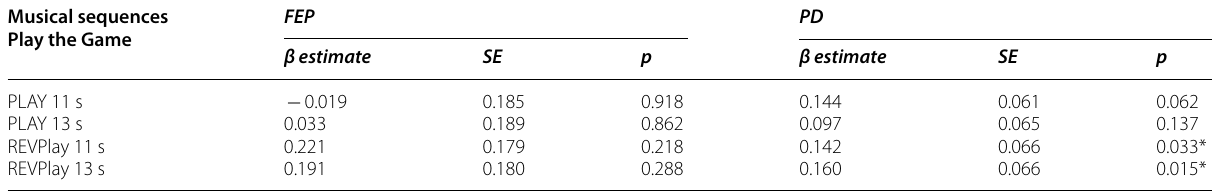
Note: Difference between groups * p < 0.05. Please note that these results for the musical sequences PLAY have not yet been published previously for FEP patients and are not reported in de Bustamante Simas et al.